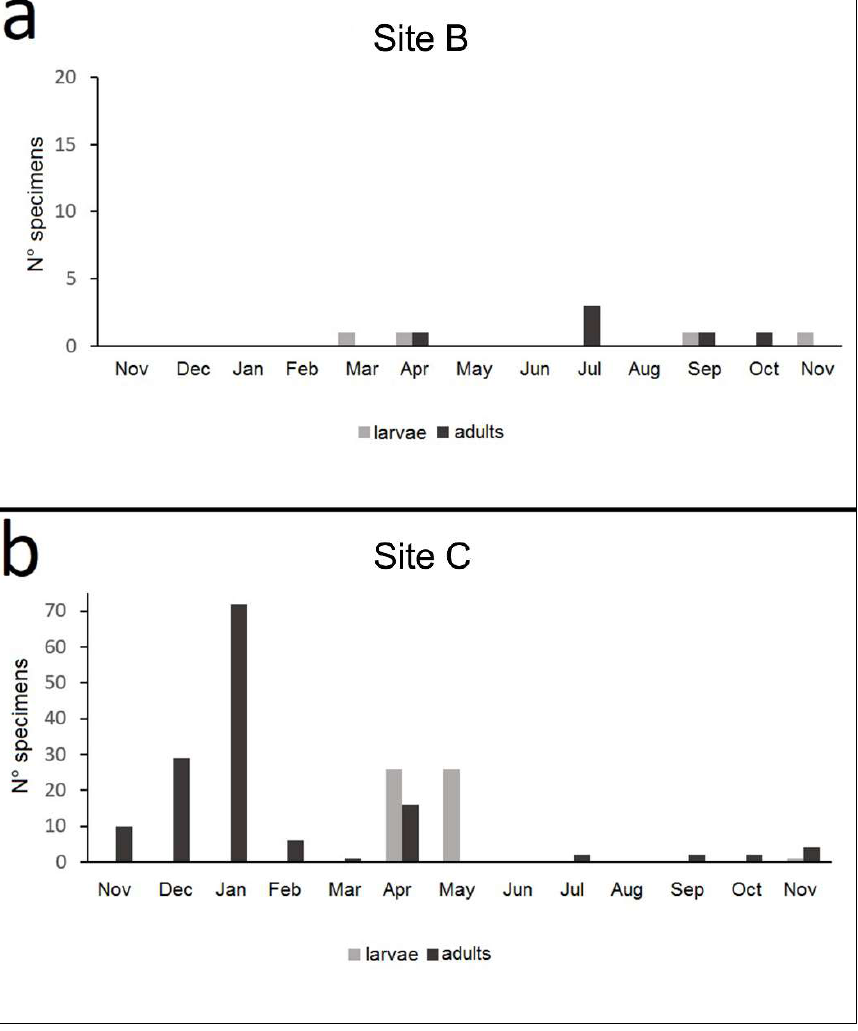
Figure 6. Number of specimens of Nebrioporus ceresyi , both larval and adult, during the year in sites B ( a ) and C ( b